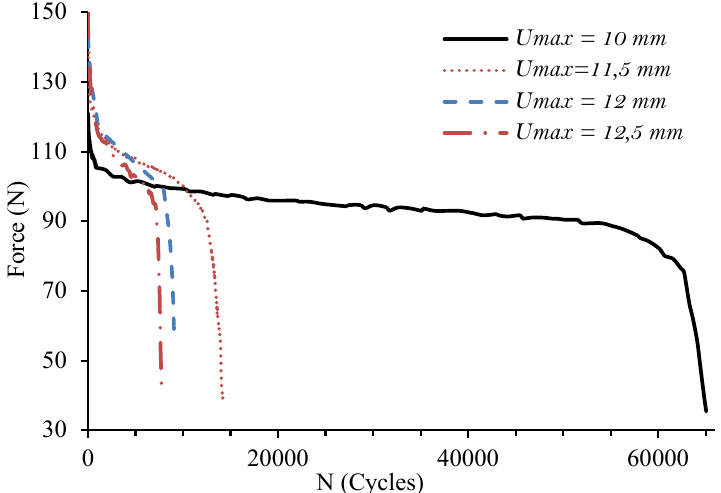
Figure 11. Experimentally measured force-cycle history for PA66GF20 specimens.